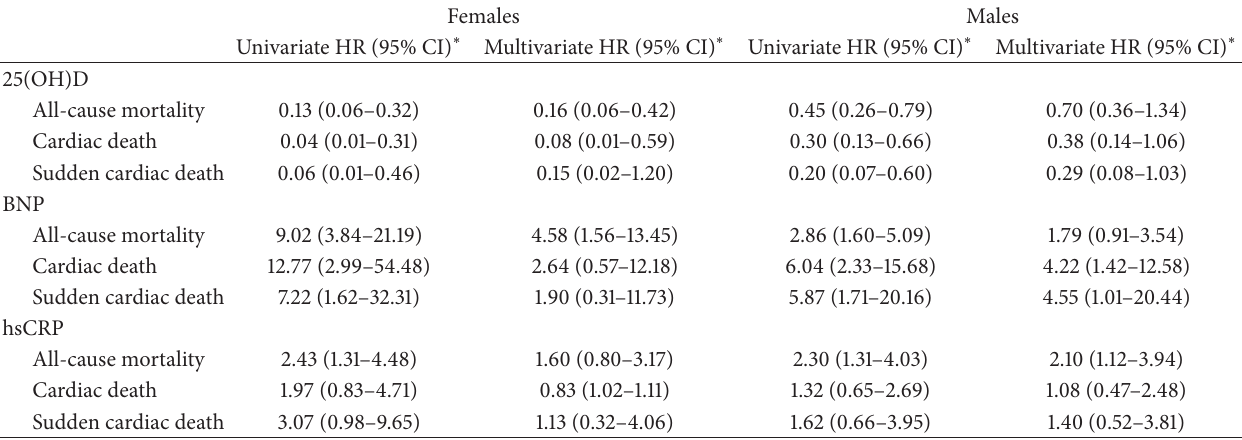
Table 3: Hazard ratios for 25(OH)D, BNP, and hsCRP in univariate and multivariate analyses in both gender.